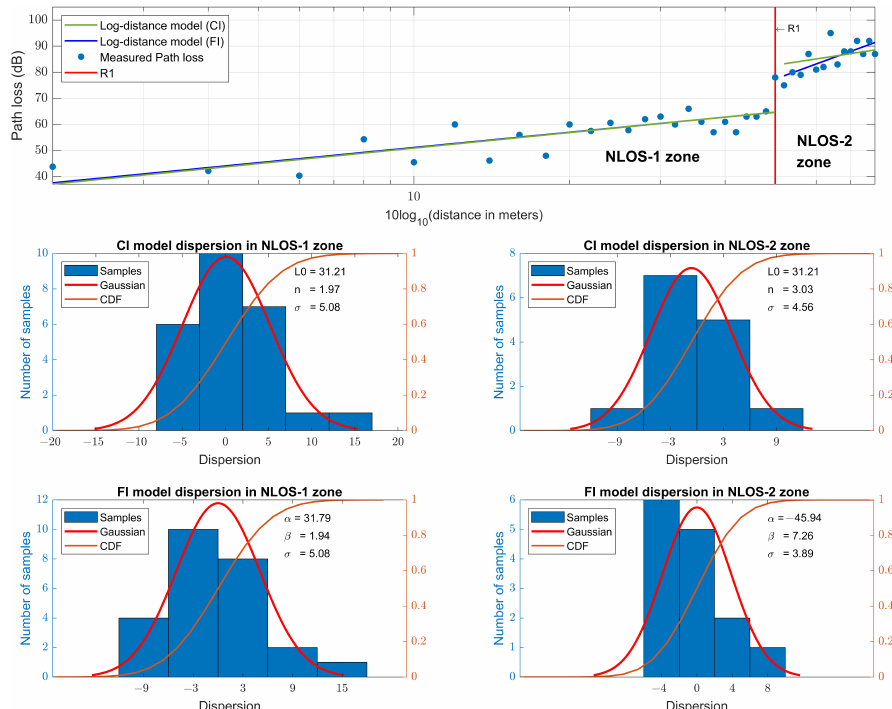
Figure 7. Narrowband path loss models at 868 MHz and their